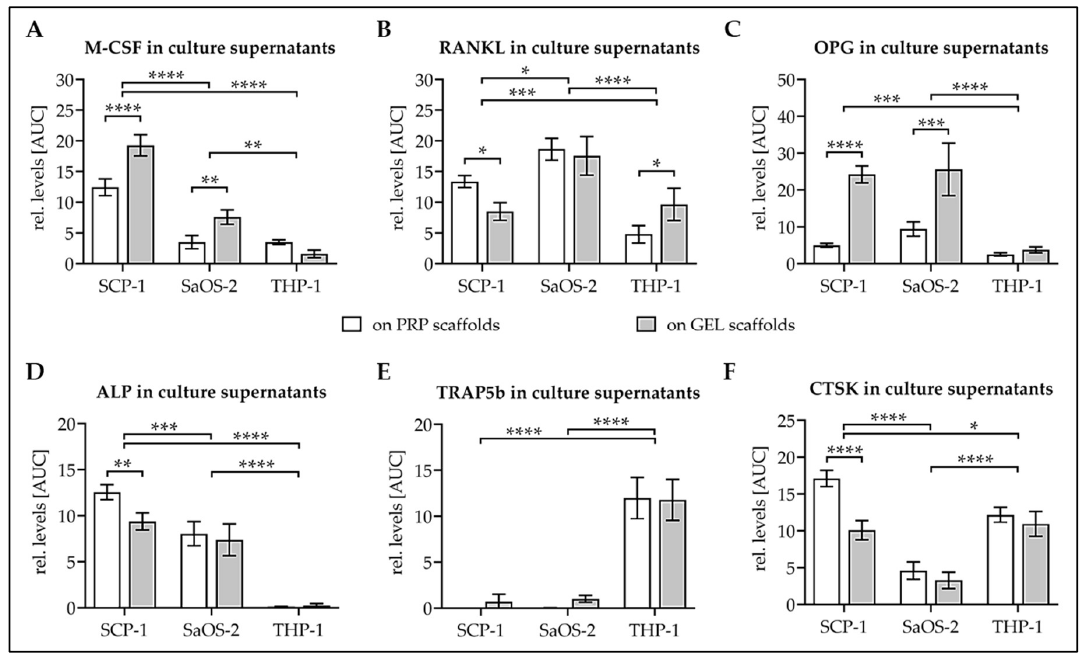
Figure 5. Factors secreted into the culture medium by the different cells on the two scaffolds. Twenty thousand SCP-1 cells, 4 × 10 4 SaOS-2 cells, and 8 × 10 4 THP-1 cells were seeded on each scaffold and differentiated for 14 d. On days 4, 7, and 14, conditioned medium (72 h) was collected. Dot blot analysis was performed to determine relative levels of ( A ) macrophage colony-stimulating factor = M-CSF, ( B ) receptor activator of nuclear factor kappa-Β ligand = RANKL, ( C ) osteoprotegerin = OPG, ( D ) alkaline phosphatase = ALP, ( E ) tartrate-resistant acidic phosphatase 5b = TRAP5b, and ( F ) cathepsin K = CTSK. Each experiment was performed three times (N = 3) in triplicates (n = 3). AUC = area under the curve, summarizing the 14 days of differentiation. Two-way ANOVA was used for data comparison between groups. * p < 0.05, ** p < 0.01, *** p < 0.001, and **** p < 0.0001 as indicated.